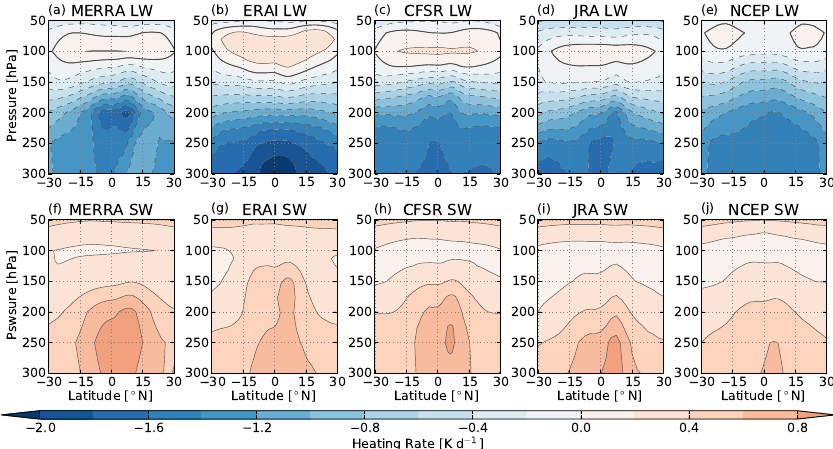
Fig. 4. Zonal mean (a) – (e) long-wave and (f) – (j) short-wave components of radiative diabatic heating averaged over the period 2001–2010.